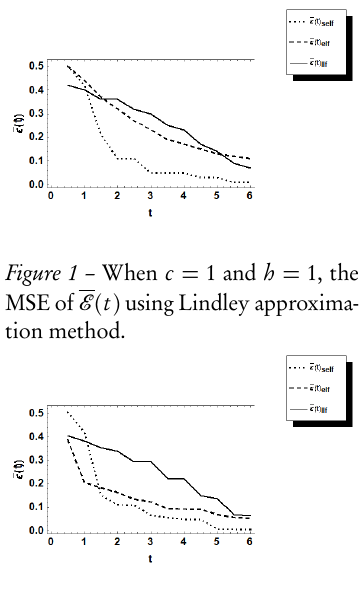
Figure 3 – When c = 2 and h = 2, the MSE of (cid:69) ( t ) using Lindley approxima- tion method.